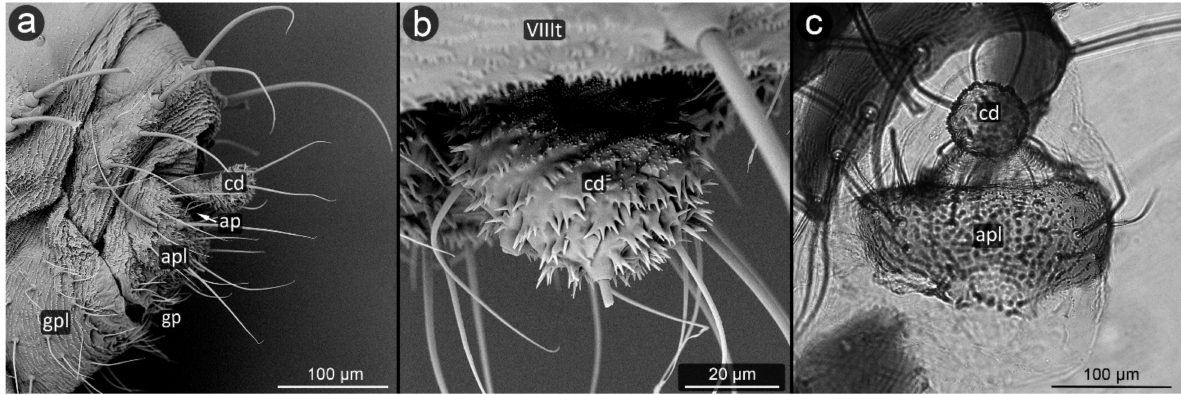
Figure 9. Perianal structure of Chaitophorus populeti ; ( a )—lateral view (SEM), ( b )—close-up on the surface of cauda-protruding spinules (SEM), ( c )—rear view in light microscopy. Aphis jacobaeae Schrank, 1801 (Figure 10).